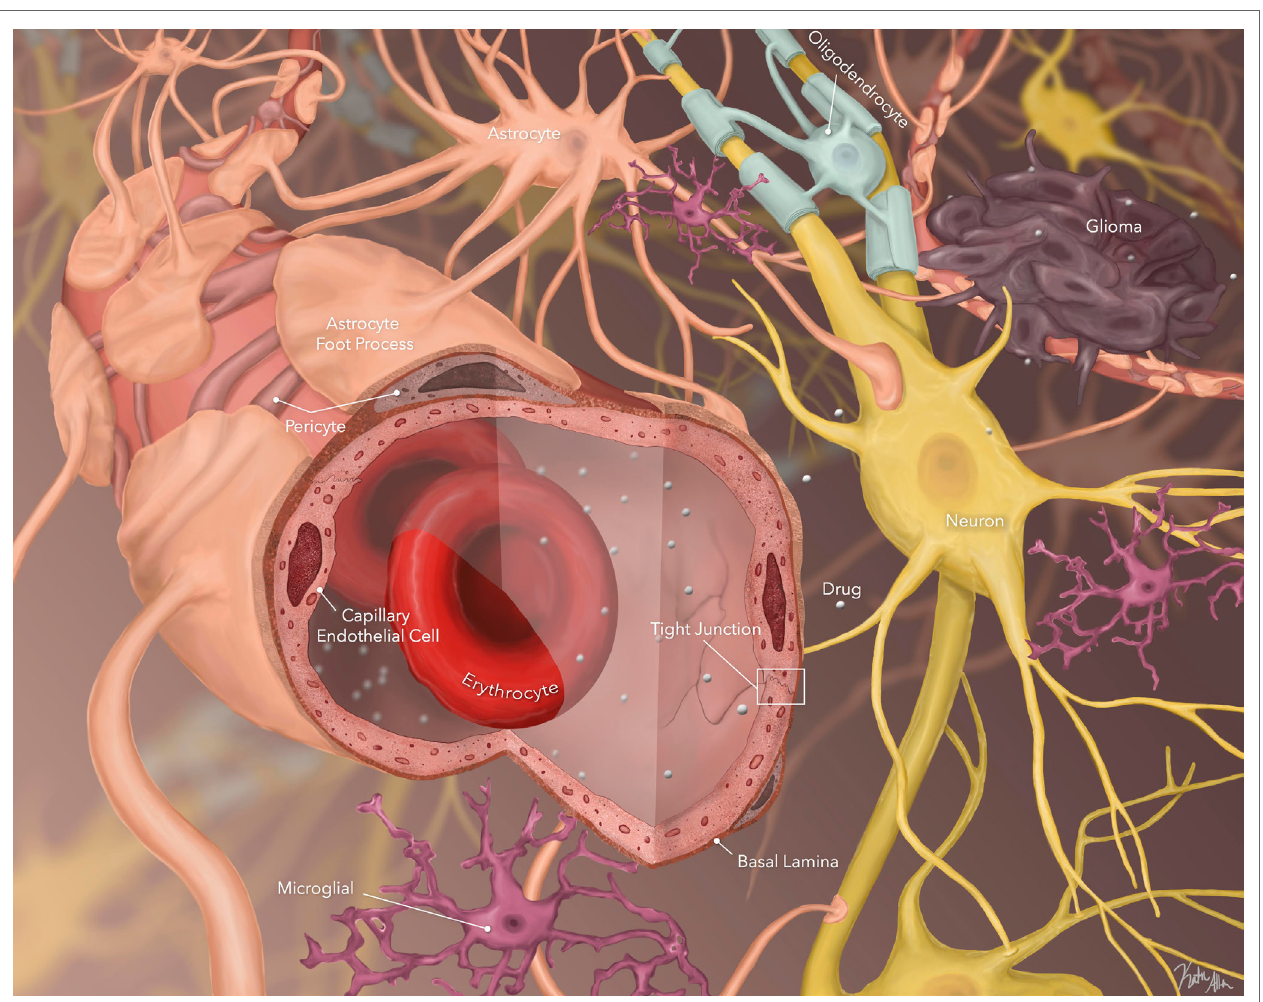
FiGURe 1 | Schematic of blood:brain barrier (BBB), brain parenchyma, and stroma. Small, unbound, lipophilic agents are able to cross the BBB. They then must cross through brain parenchyma by diffusion across the extracellular space to reach tumor cells ( image by Katie Allen